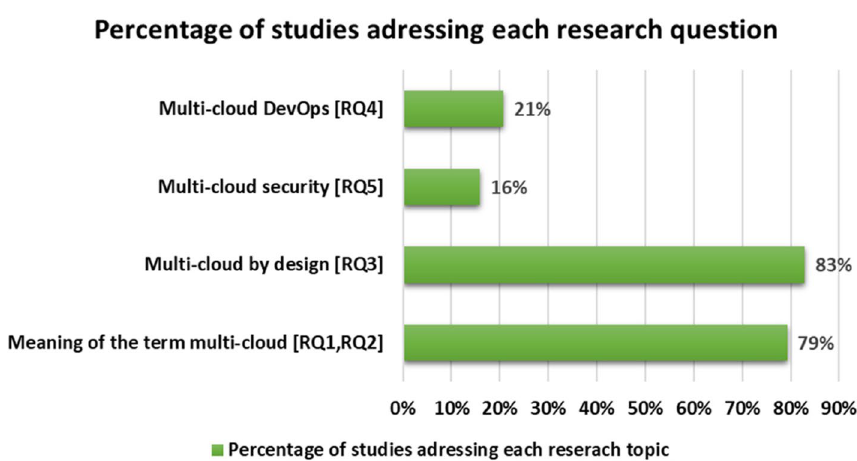
Fig. 12 Percentage of studies addressing each research question from Section